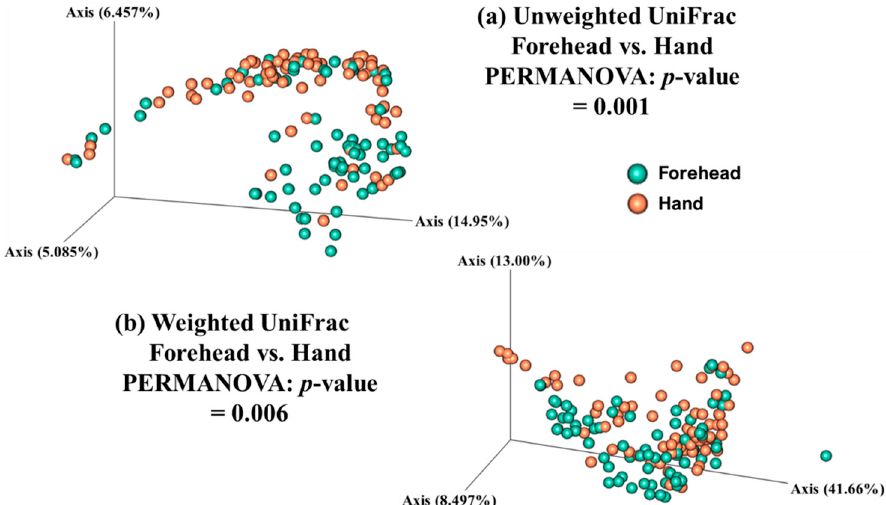
Figure 4. Skin microbiota distribution between the forehead and hand based on the ( a ) unweighted and ( b ) weighted UniFrac distances. Non-parametric Permutational Multivariate Analysis of Variance (PERMANOVA) was used to compare the skin microbiota between the forehead and hand.